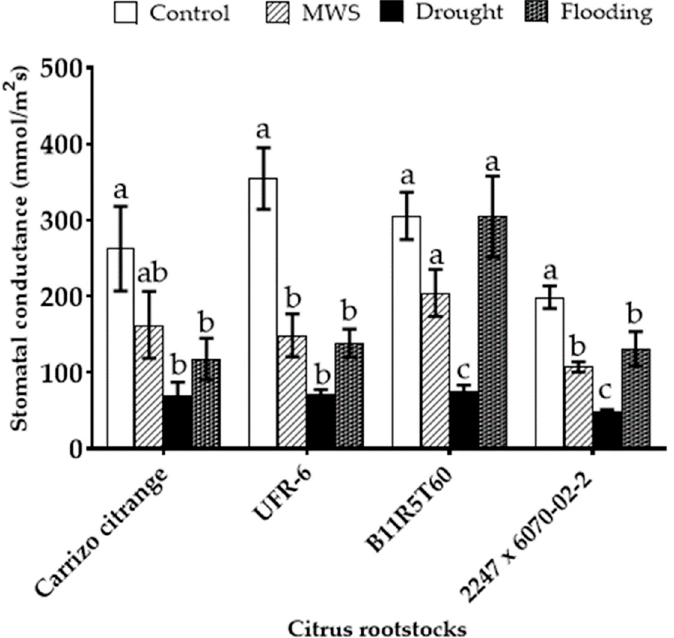
Figure 5. Mean stomatal conductance (mmol/m 2 s) at the end of the experiment with four water treatments (Control, MWS, Drought, and Flooding) using four citrus rootstocks (Carrizo citrange, UFR-6, B11R5T60, and 2247 x 6070-02-2). Values in columns with different letters denote statistical differences among the treatments for each rootstock by Fisher’s LSD test ( p < 0.05). MWS: Medium Water Stress.